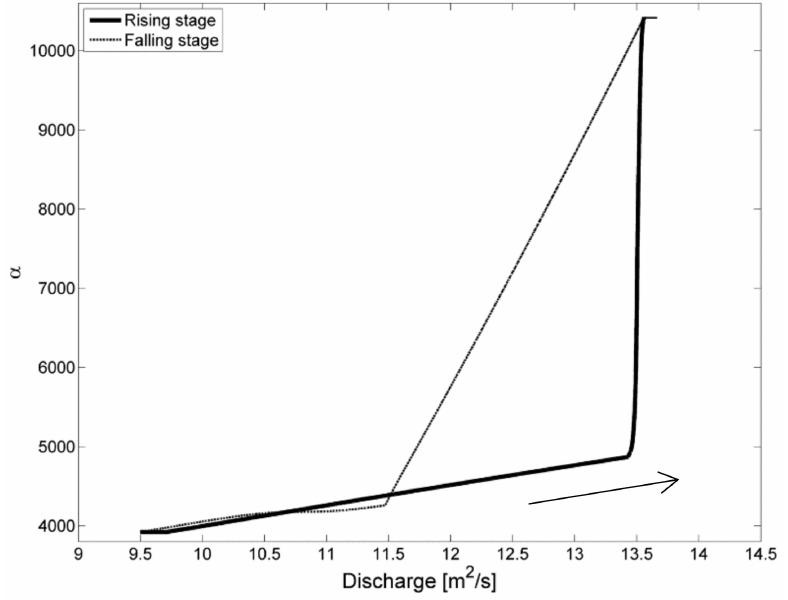
Figure 20. Specific discharge versus non-dimensional step length α separated for the rising and falling stages of the hydrograph, using the more extreme river scenario. The arrow signifies the direction of development over